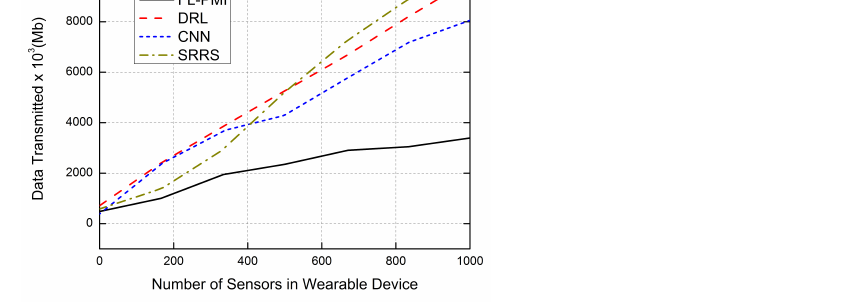
Figure 12. Comparative analysis of data transmitted concerning the number of sensors in the wearable